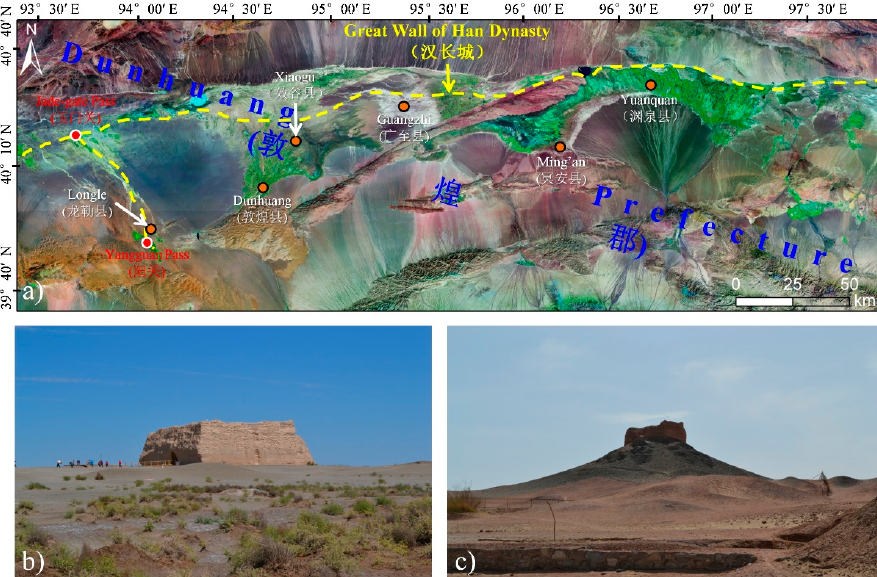
Figure 3. ( a ) Map of ancient Dunhuang Prefecture and the Dunhuang Section of GH; the yellow dotted lines represent the general location of GH; the names in white text indicate the approximate locations of the major oasis counties during the Early Han Dynasty. The basemap for ( a ) was the Enhanced Thematic Mapper Plus (ETM+) imagery, which can be downloaded from http://www.usgs.gov. ( b ) Photograph of a military fort at the Jade-gate Pass; ( c ) photograph of a beacon tower at Yangguan Pass.